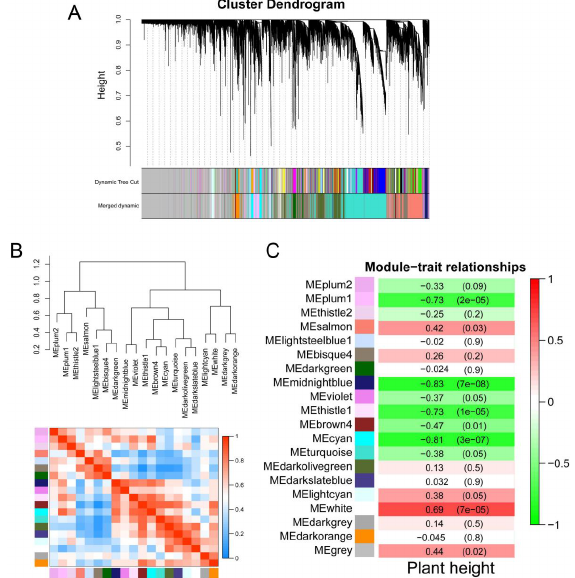
Figure 5. WGCNA at different growth stages of ‘BX’ and ‘RK’. ( A ) Hierarchical clustering tree (cluster dendrogram) of all expressed genes. Co-expression modules were identified by WGCNA at different growth stages. Each leaf in the tree represents one gene. The branches correspond to modules of highly interconnected groups of genes. The different colors represent different gene modules. The major tree branches constituted 20 modules; ( B ) module-relatedness clustering and heatmap of correlation in each module; ( C ) heatmap chart showing module-plant height correlation and p -values. The color scale ranging from green to red indicates negative and positive correlations between the module and plant height. The numbers in brackets represent the p -values. The modules of bisque4 and salmon were positively related to plant height, and con- tained 1549 and 1560 genes, respectively. Combining with DEG analysis, six genes from GA-mediated signaling pathway (GO: 0009937, GO: 0009939, GO: 0009740) and two genes from IAA biosynthesis (ko00901) were obtained from the bisque2 module (Figure 6A). Int. J. Mol. Sci. 2023 , 24 , x FOR PEER REVIEW were significantly enriched in both the bisque4 and salmon modules (Figures 6B and S1B). A total of 52 and 35 hub genes were identified from the bisque4 and the salmon, respec-